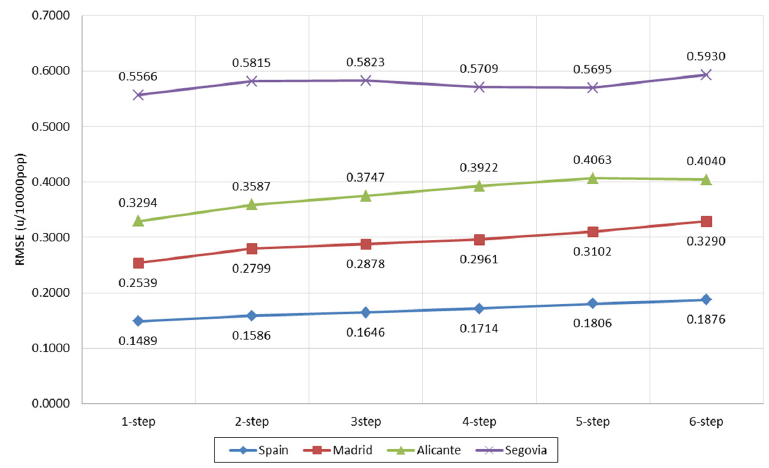
Figure 5. Evolution of RMSE in 6-step GBV complaints’ forecast, performed by FS dataset MOES-RF and RF as predictive techniques for different territories. Table 6. Average RMSE to 6-step GBV complaints forecasting in different territories.